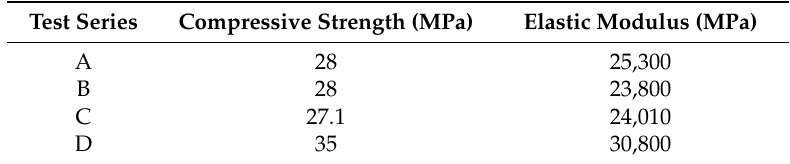
Table 3. Compressive strengths and elastic moduli of concretes of four test series at 28